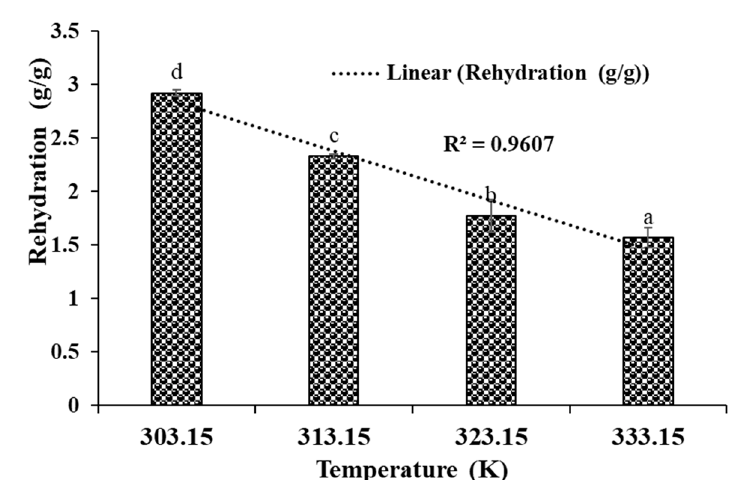
Figure 5. Effect of drying temperature on rehydration of Kyoho skin powder. Error bar represents the standard deviation of the mean and different letters (a to d) indicate significant difference ( p < 0.05).